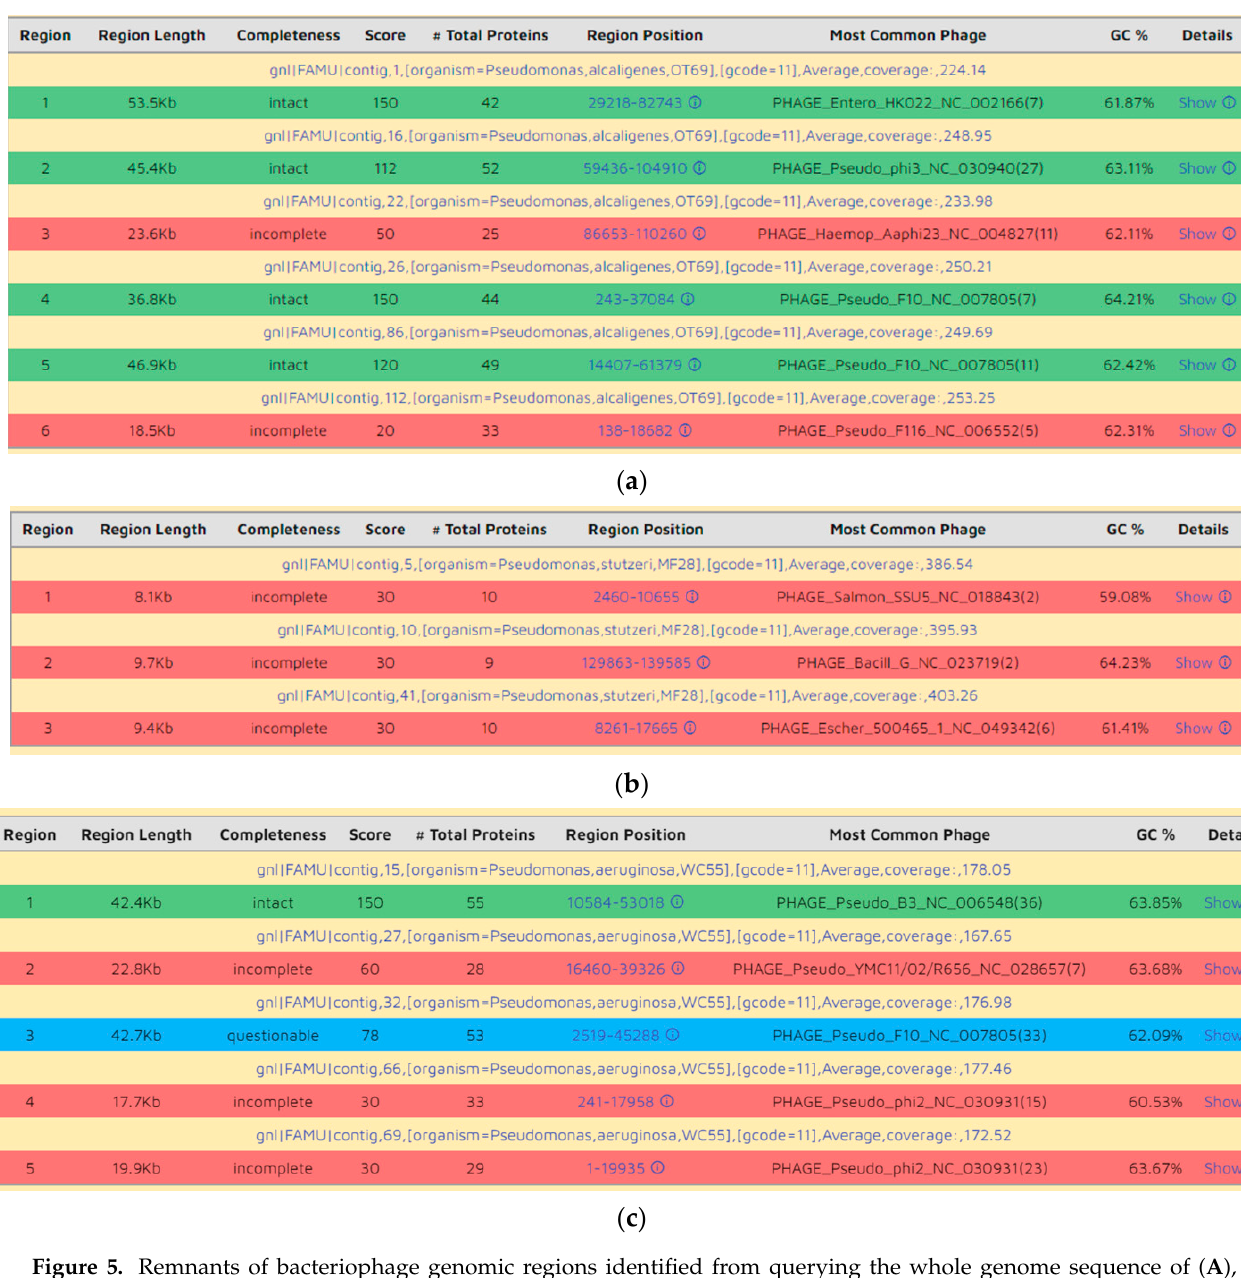
Figure 5. Remnants of bacteriophage genomic regions identified from querying the whole genome sequence of A , Pseudo- monas alcaligenes OT69; B , Pseudomonas stutzeri MF28 and C , Pseudomonas aeruginosa WC55. The boxes are color coded with intact prophage shown in green color, incomplete in red color and questionable in blue color, respectively.